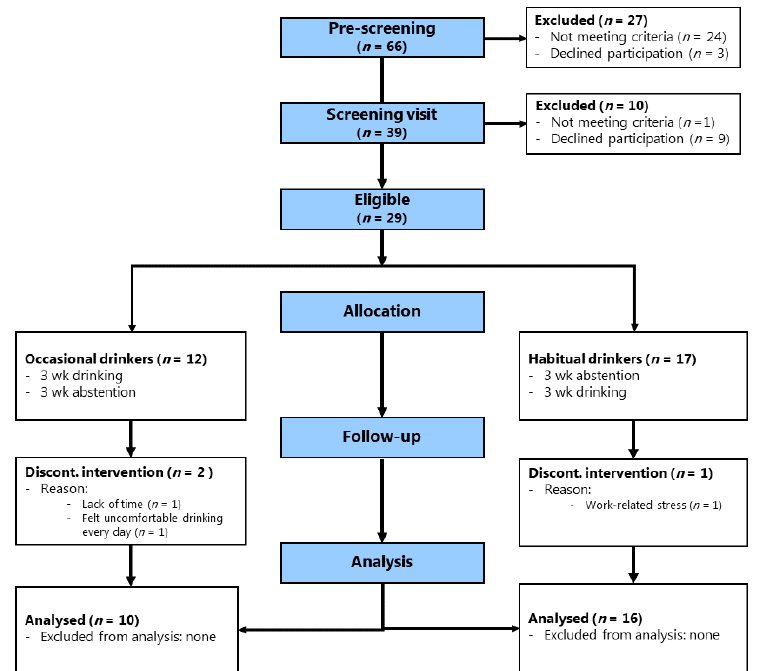
Figure 2. Flow of study participants in MetAl. Occasional drinkers: habitual alcohol intake <2 drinks (~24 g) per week. Habitual drinkers: habitual alcohol intake ≥ 2 drinks (~24 g) per week, max 1 drink per day for women and 2 drinks per day for men. Table 2. Baseline characteristics of MetAl participants by group.